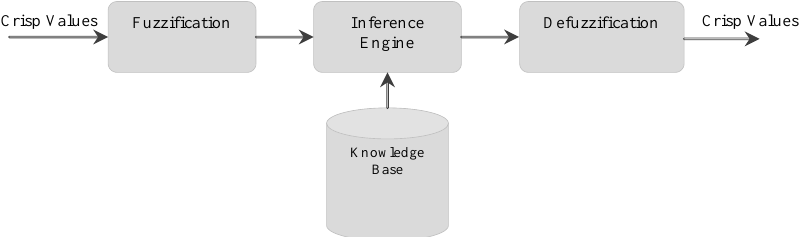
Figure 1. Structure of a fuzzy logic model (Osofisan,